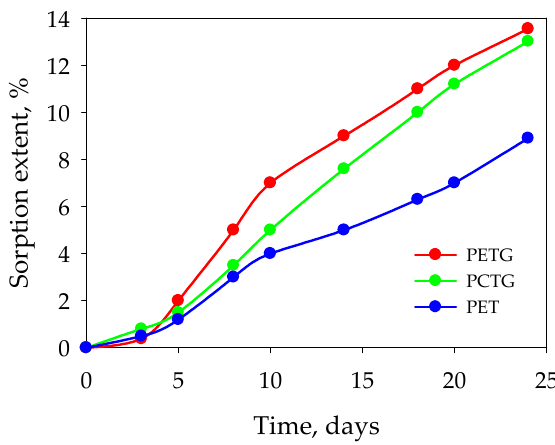
Figure 3. Sorption in the vapor phase of ethyl acetate. T = 20 °C in the first 24 h.